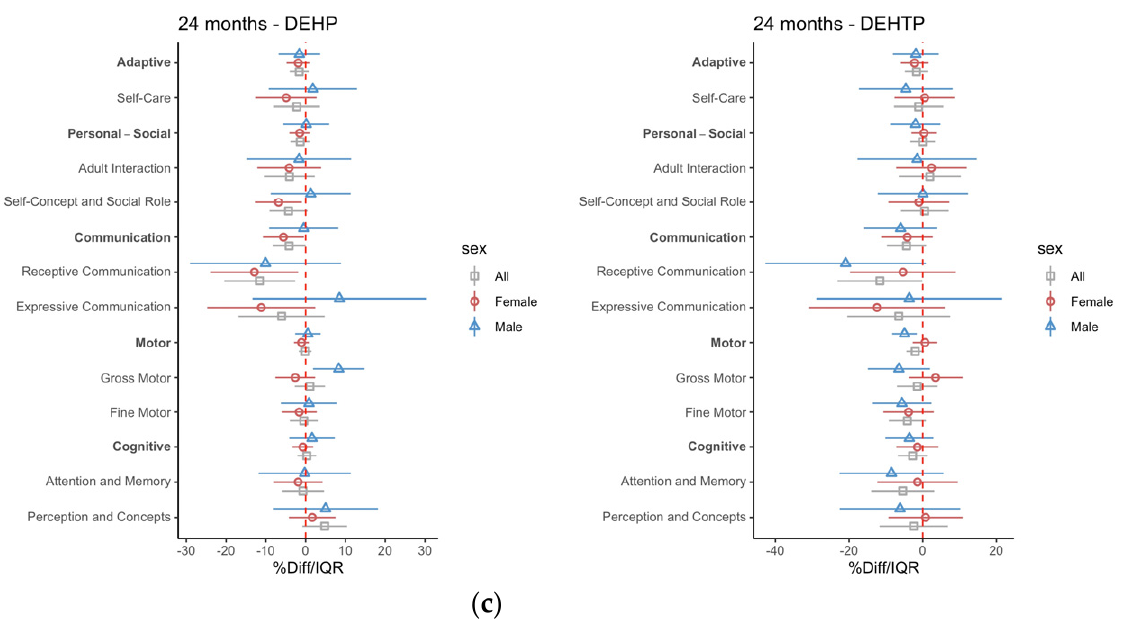
Figure 3. ( a ). Percentage change in BDI-2 scores at 6 months of age (n = 98) per IQR increase in the geometric mean of maternal urinary phthalate metabolite concentrations (ng/mL) across pregnancy. ( b ). Percentage change in BDI-2 scores at 12 months of age (n = 98) per IQR increase in the geometric mean of maternal urinary phthalate metabolite concentrations (ng/mL) across pregnancy. ( c ). Percentage change in BDI-2 scores at 24 months of age (n = 98) per IQR increase in the geometric mean of maternal urinary phthalate metabolite concentrations (ng/mL) across pregnancy.